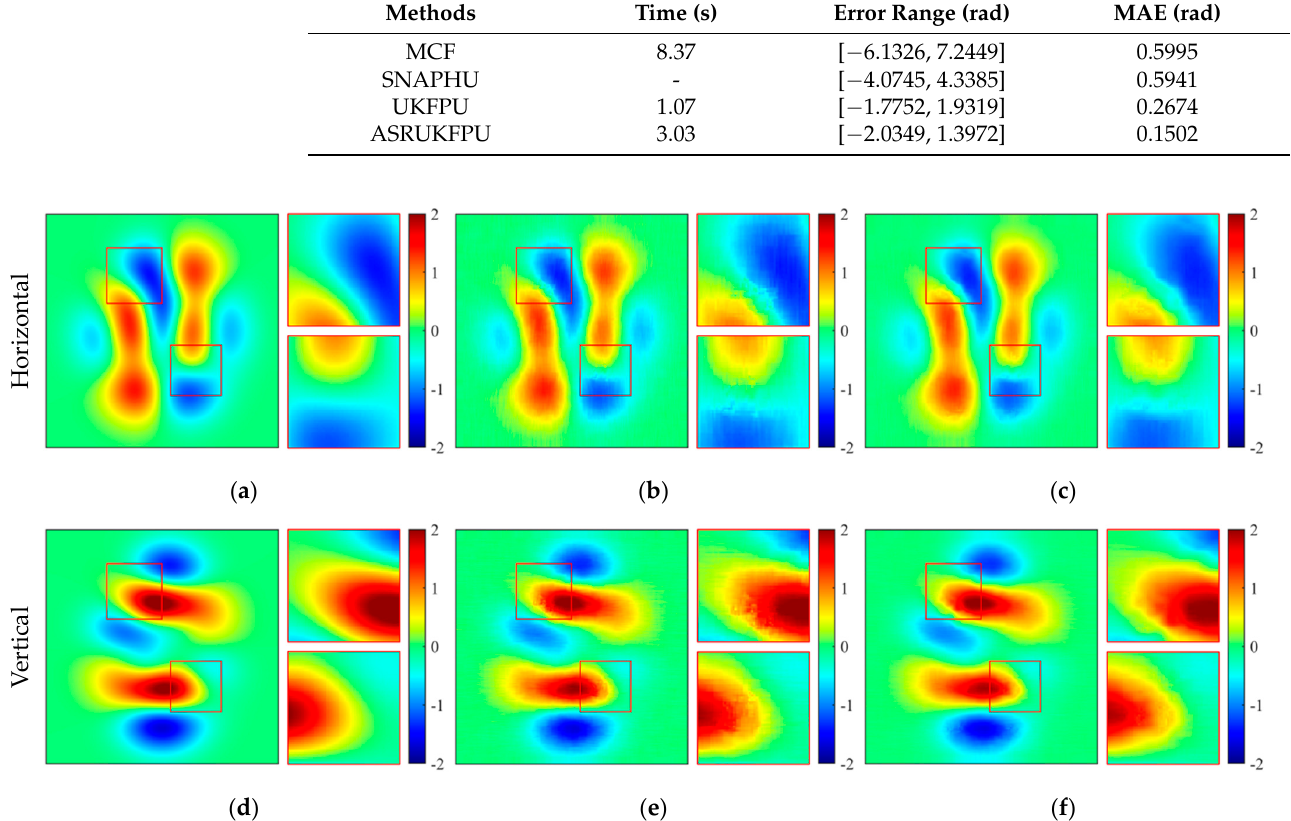
15 of 23 Figure 4. Unwrapped maps (units are rad), PU error distribution maps (units are rad) and estima- tion error histograms: ( a )– ( c ) are the results obtained by MCF; ( d )–( f ) are the results obtained by SNAPHU; ( g )–( i ) are the results obtained by UKFPU; ( j )–( l ) are the results obtained by ASRUKFPU. In addition, based on the simulated dataset, we analyzed the improved parts of the ASRUKFPU. We combined the modified PGE with the adaptive window into the UKFPU but did not detect the continuity of the phase frequency estimation results, and revised the outliers. Using this method to unwrap the simulated noisy interferogram, the MAE of the unwrapped results is 0.1693 rad. In Table 1, the MAE of the unwrapped results of the UKFPU, combined with the local frequency estimation method based on AMPM, are 0.2674 rad; this indicates that the frequency estimation results of the modified PGE are